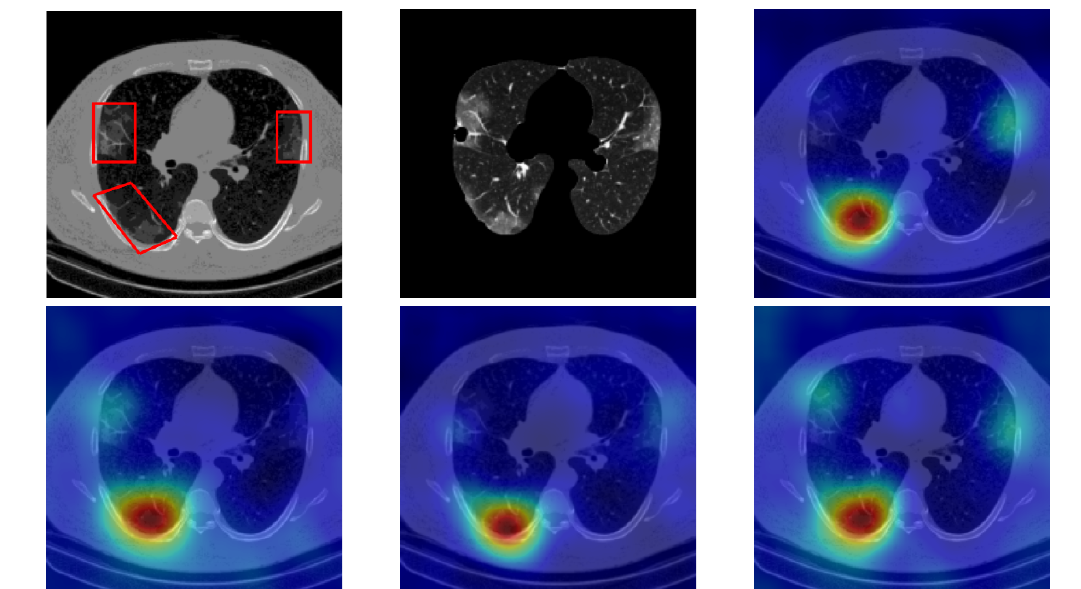
Figure 13. RISE heat map examples of COVID-19 slice images using the trained multi-tasks CNN architectures (ResneXt-50, Densenet-161, Inception-v3, and Wide-Resnet-50). The first example is shown in the first two rows, where the images represent the input slice image and segmented lung lobes results, followed by the heat maps of ResneXt-50, Densenet-161, Inception-v3, and Wide-Resnet-50, respectively. The second example is in rows 3 and 4.